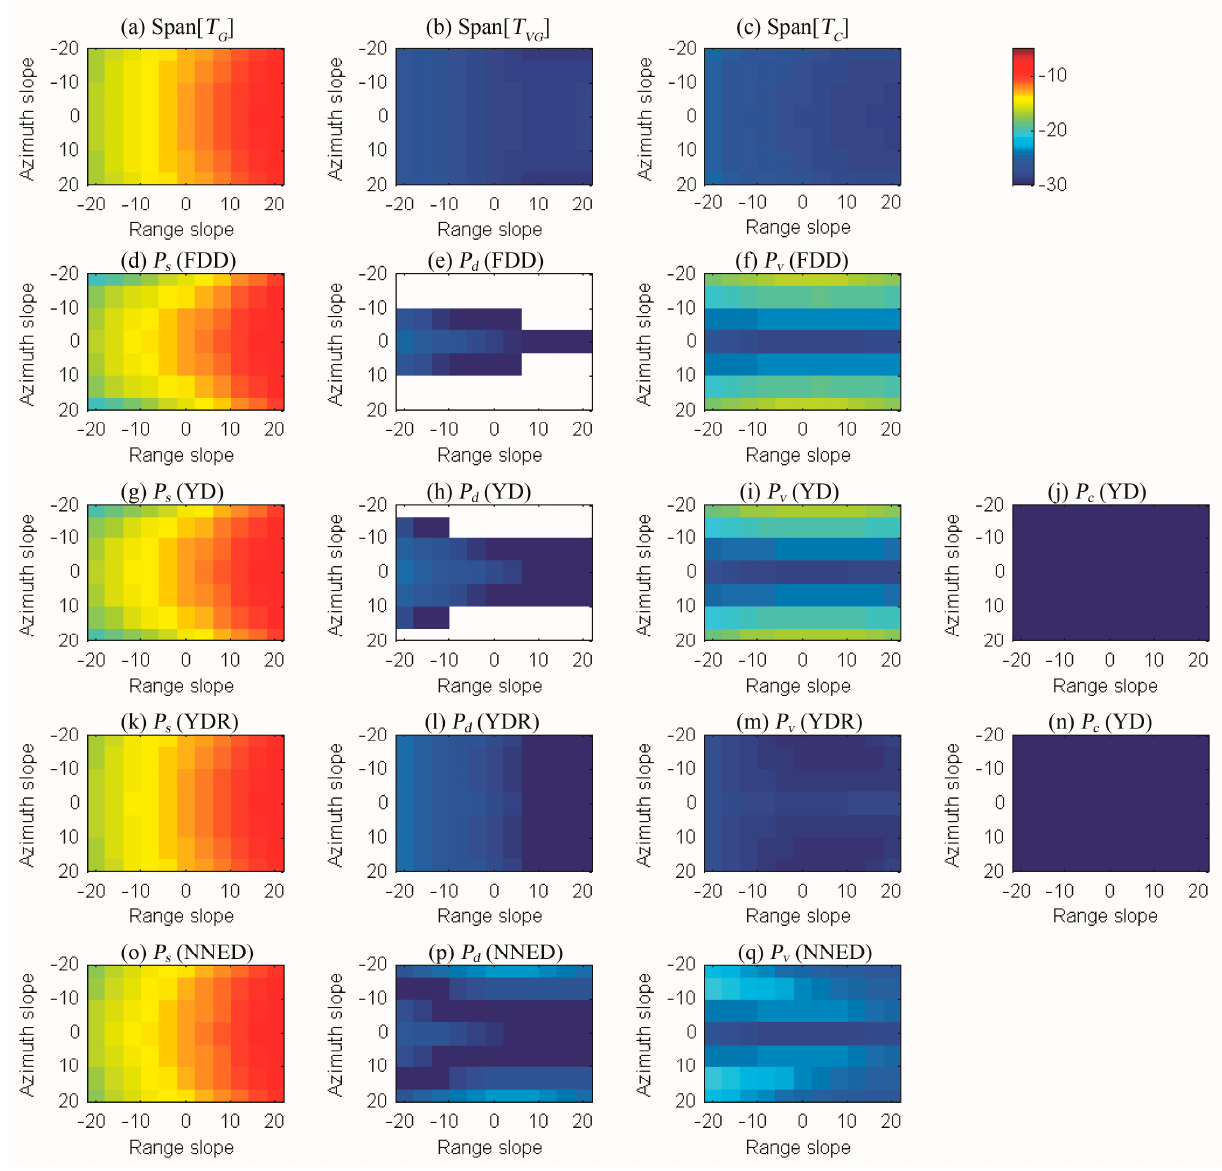
Figure 2. Changes in the scattering mechanisms with respect to the terrain range and azimuth slopes for S1. ( a – c ) Reference scattering mechanisms (ground, vegetation-ground and canopy scattering, respectively) of the simulated coherency matrix. ( d – f ) Calculated scattering components from the Freeman–Durden decomposition (FDD) method. ( g – j ) Calculated scattering components from the Yamaguchi decomposition (YD) method. ( k – n ) Calculated scattering components from the Yamaguchi decomposition with orientation compensation (YDR) method. ( o – q ) Calculated scattering components from the non-negative eigenvalue decomposition (NNED)